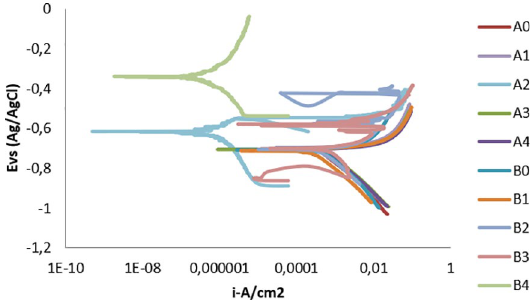
Figure 2. Polarization curves of unreinforced and reinforced ZA-27 alloy composites in 0.3M H